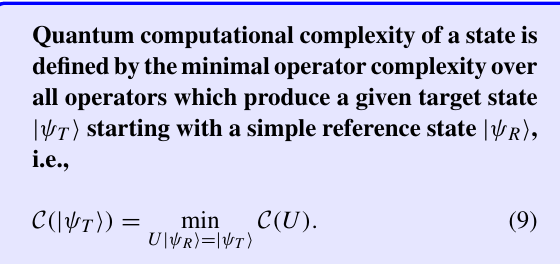
can show that if a circuit can be built with m gates, then it can be build with O ( m log c ( m (cid:11) )) gates from a different uni- versal set [48]. Combining the estimate in Eq. (8) with the Solovay–Kitaev theorem, one can show that a unitary over N qubits may be approximated with tolerance (cid:11) using at most O ( N 2 2 2 N log c ( N 2 2 2 N /(cid:11)) gates